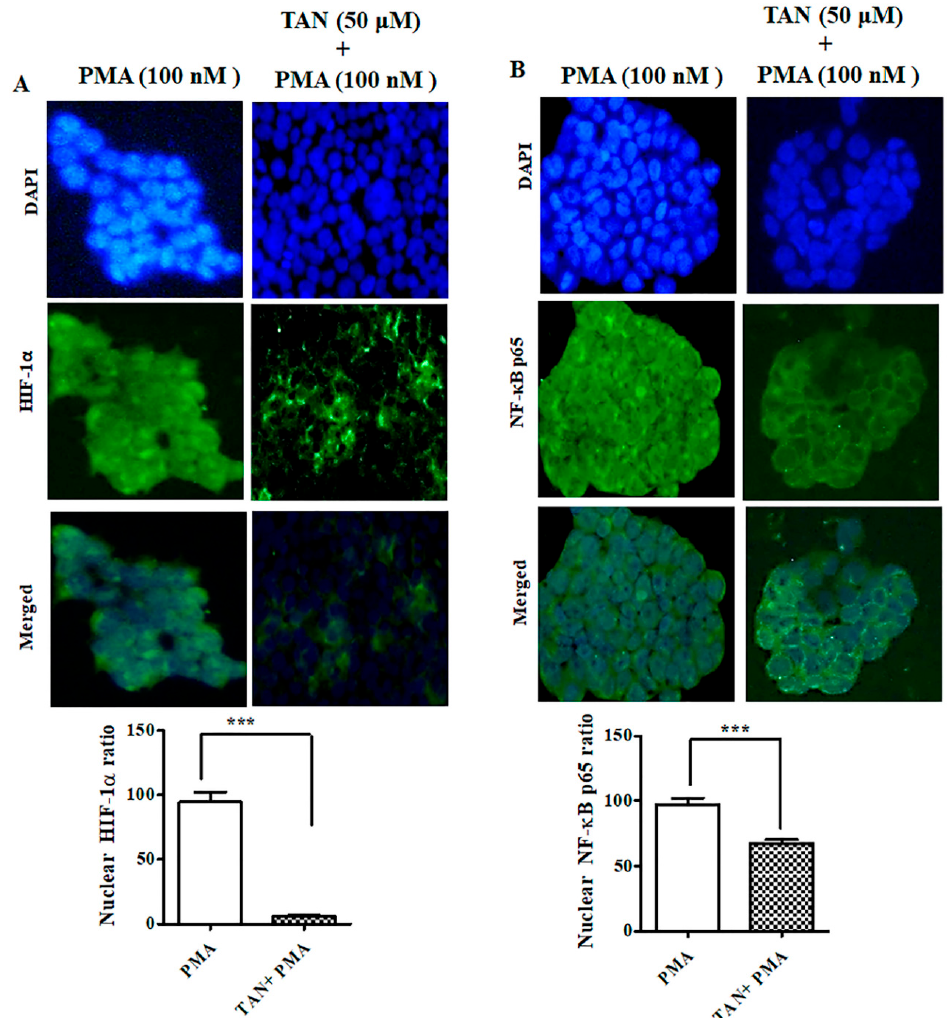
Figure 9. TAN inhibited PMA induced NF- κ B-p65 and HIF-1 α nuclear translocation on HaCaT cells. ( A ) Immunofluorescence staining of HIF-1 α after treatment with tangeretin (50 μ M, 24 h) and PMA (100 nM, 4 h), ( B ) Immunofluorescence staining of NF- κ B-p65 after treatment with tangeretin (50 μ M, 24 h) and PMA (100 nM, 4 h). Scale bar (100 μ M). Magnification = 200×. *** p < 0.001.